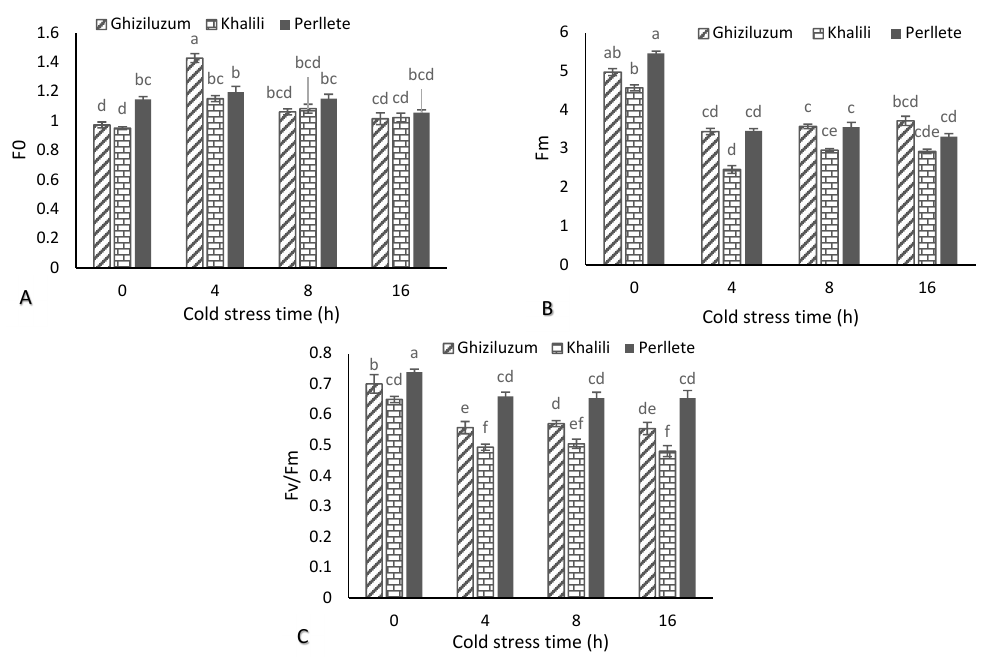
Figure 2. The effects of cold stress time-course on F0 (minimal fluorescence) ( A ), Fm (maximal fluorescence) ( B ) and Fv/Fm (maximum photochemical quantum yield of photosystem II) ( C ) of three grapevine cultivars. Similar letters show no meaningful difference at 5% probability level by Duncan’s Multiple Range Test. Data are mean ± SD ( n = 3).